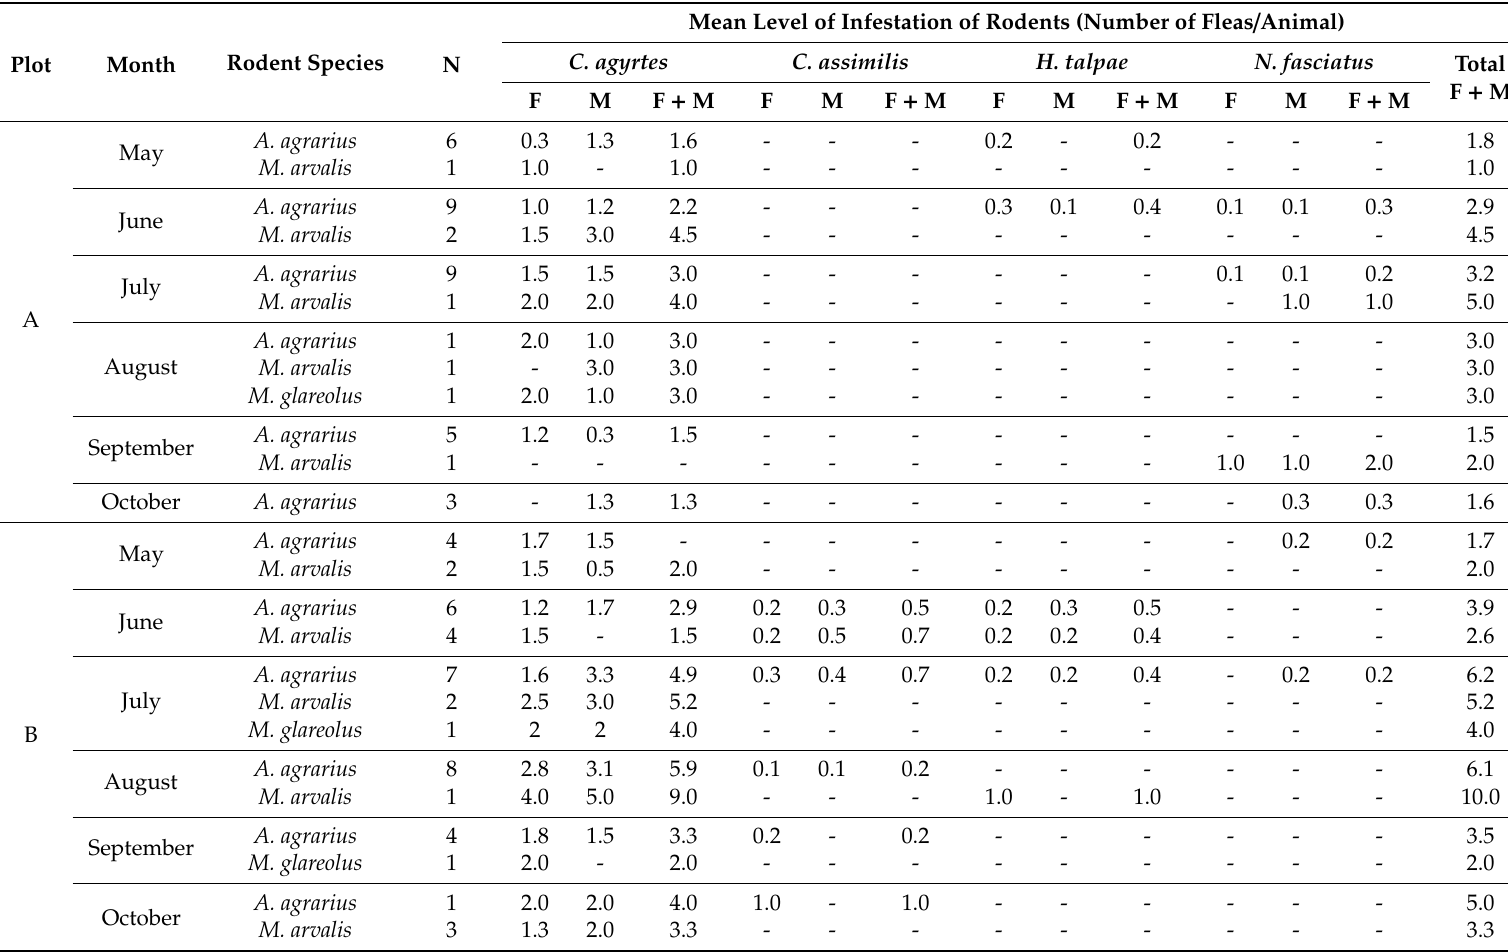
Table 2. Mean level of flea infestation of animals trapped in plots A, B and C (values rounded to 0.1), (N—number of rodents, F—females, M—males). Mean Level of Infestation of Rodents (Number of Fleas / Plot Month Rodent Species N